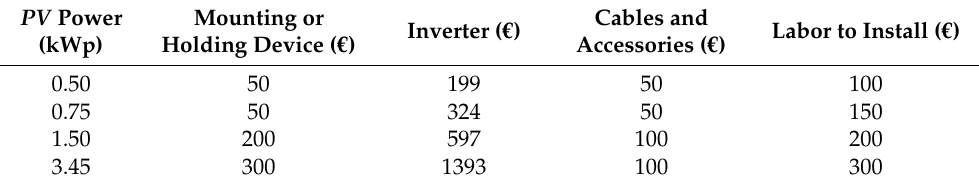
Table 1. Condition estimated equipment and installation prices